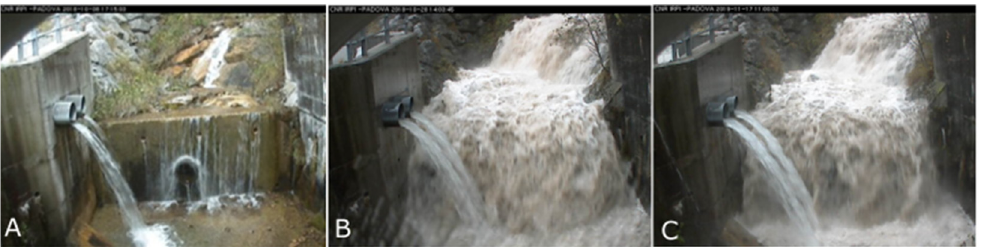
Figure 6. Rio Verde Discharge—( A ): ordinary days; ( B ): during the Vaia storm; ( C ): during the 2019 event.